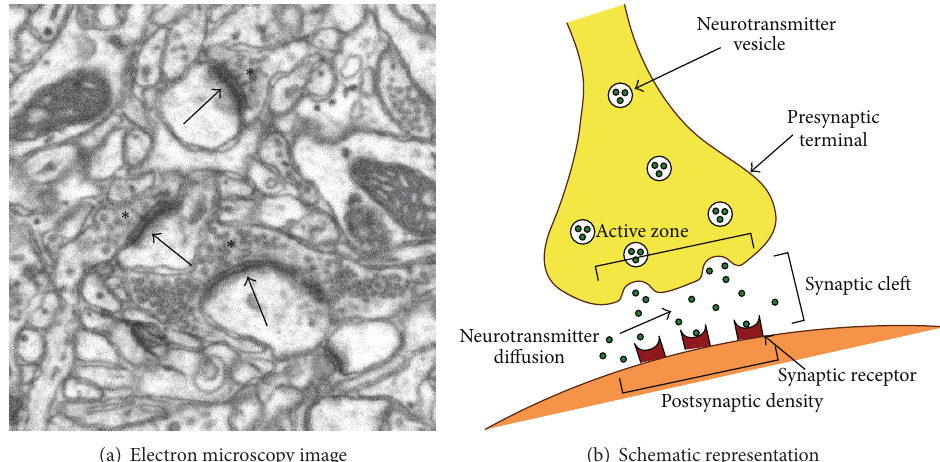
Figure 1: Chemical synapses. (a) Electron microphotograph of the cerebral cortex where three axon terminals (asterisks) establish synapses with three dendritic elements showing clearly visible postsynaptic densities (arrows). (b) Simplified model of a chemical synapse, highlighting its most significant